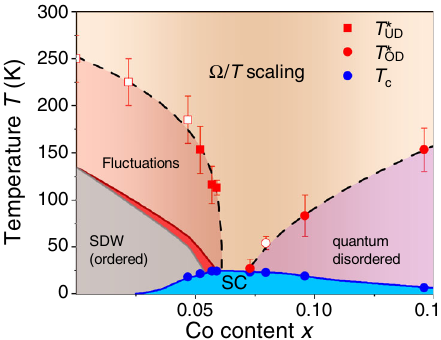
Fig. 3 Phase diagram of Ba(Fe 1 − x Co x ) 2 As 2 . The spin-density-wave (SDW) phase is depicted in gray, nematicity in red, and superconductivity (SC) in blue as de fi ned by the superconducting transition temperature T c . The rectangular and circular data points indicate the crossover temperatures T (cid:3) and T (cid:3) from the region of Ω / T scaling for x < x c and x > x c , UD OD respectively. The dashed lines are guides to the eye. Open red squares and circles represent data points from Lederer et al. 29 . The gray, red, and blue phase separation lines are based on Chu et al. 19 . The error bars indicate the temperature window of T * depicted in Fig.